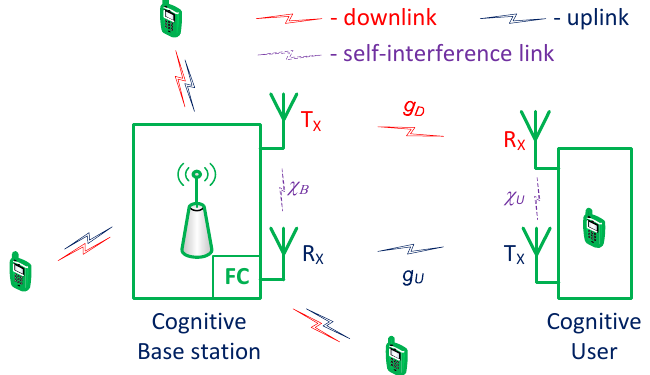
Figure 1. Model of the considered